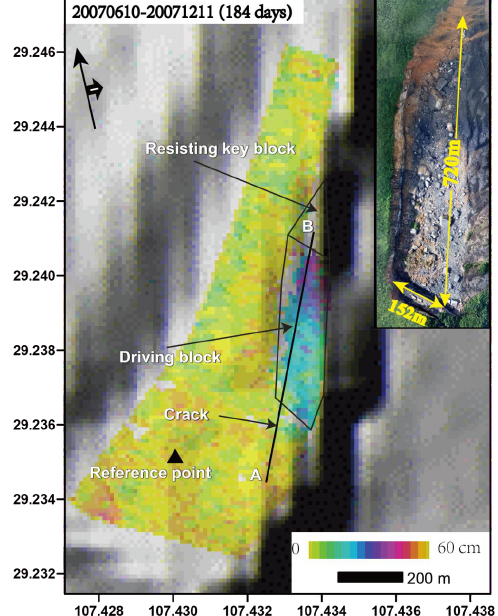
Fig. 6. The cumulative deformation map during 10 June and 11 December 2007 (184 days). Resisting key block, driving block and one of the back cracks of the Jiweishan slide are outlined. Black triangle indicates the reference point for InSAR time-series analysis. Profile AB will be discussed in Fig. 7. The inset is the aerial photograph taken after Jiweishan sliding (Yin et al., 2011).